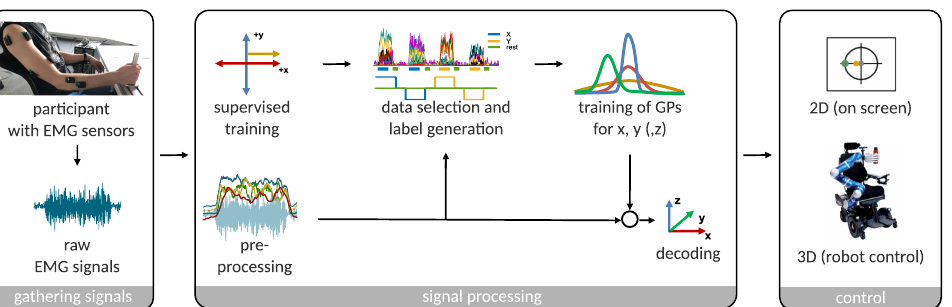
Figure 1. A schematic overview of the EMG-based interface used in this study. Gathering signals: A participant is shown with the EMG sensors, holding a handle to generate isometric muscle contrac- tions. Raw EMG signals are wirelessly transferred for further processing. Signal processing: Four time-domain features are calculated from the raw EMG signals. A supervised training procedure allows to generate the labels for the prediction. The labeled data is mapped to a velocity-based control command by the use of Gaussian process regression. Control: The interface realizes a proportional and simultaneous control output. 2D as well as 3D applications are feasible, e.g., for a commanding an assistive robot. In this study, only 2D control was realized to perform tasks on a